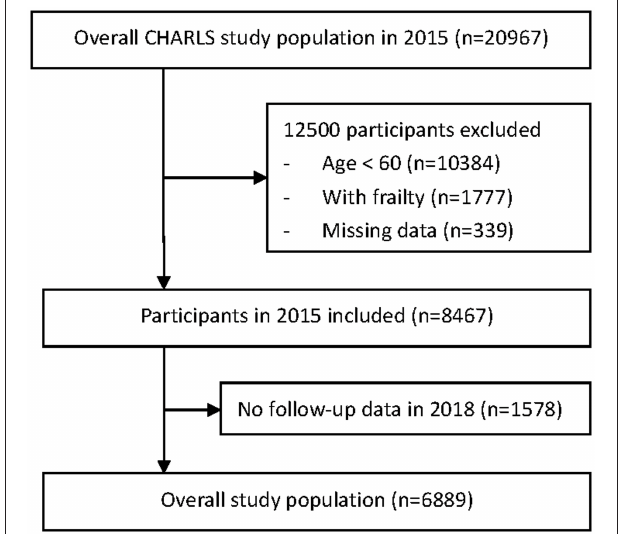
FIGURE 1 | Flowchart of participant selection from the China Health and Retirement Longitudinal Study